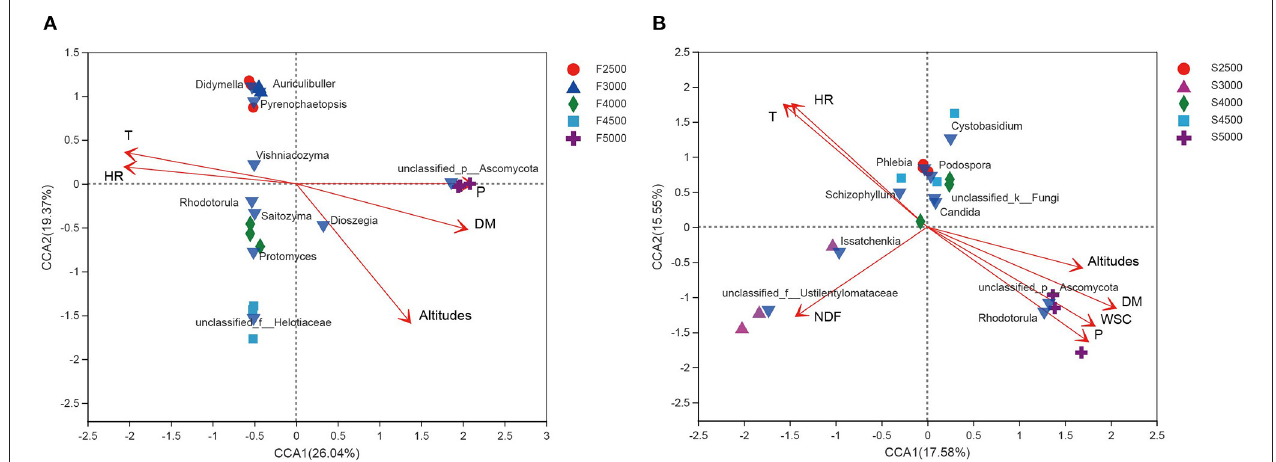
FIGURE 4 | Canonical correspondence analysis of environmental factors and fungal community of fresh (A) and ensiled (B) K. pygmaea along the elevation gradient on the Tibetan Plateau. The canonical axes are labeled with the percentage of total variance explained (%). Red arrow lengths indicate the variance explained by environmental factors, and bright blue inverted triangle represents the interpretation of the fungal community presented as a single data point. Individual samples are represented with circles, triangles, diamonds, squares, and cross. F2500, F3000, F4000, F4500, and F5000 represent samples of fresh K. pygmaea at corresponding altitude gradients. S2500, S3000, S4000, S4500, and S5000 represent samples of K. pygmaea silages at corresponding altitude gradients. T, temperature; HR, relative humidity; WSC, water-soluble carbohydrate; DM, dry matter; P, average precipitation; NDF, neutral detergent